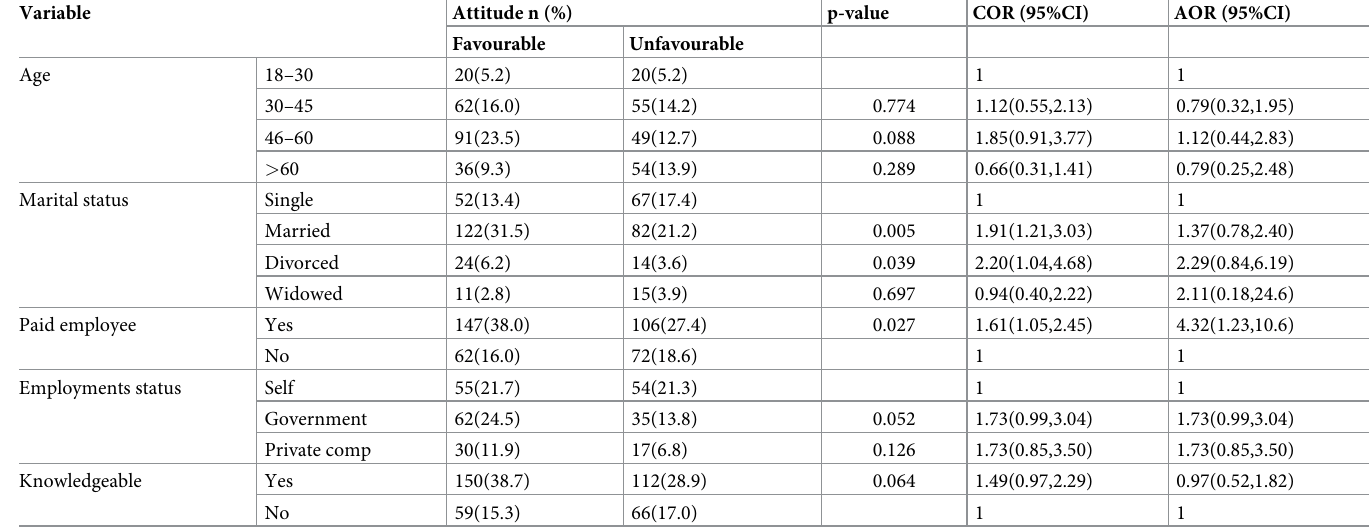
Table 8. Factors independently associated with the attitude of hypertensive patients on treatment follow up regarding lifestyle modification at Yekatit 12 General hospital in 2019 (n = 387).